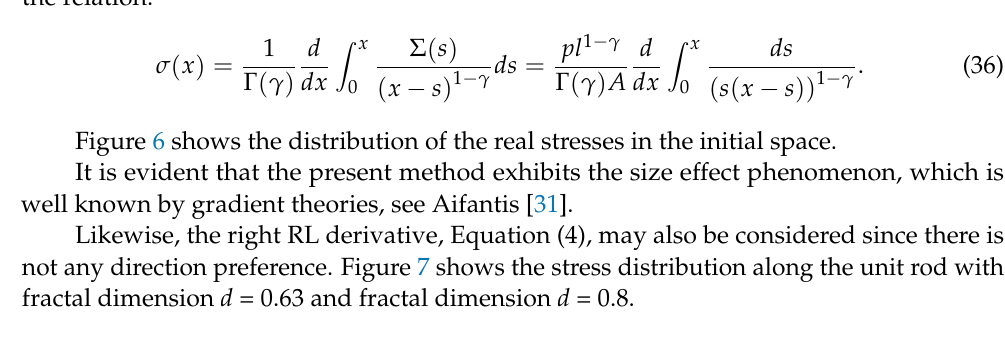
Figure 6. The non-dimensional stresses along the x -axis of the bar.